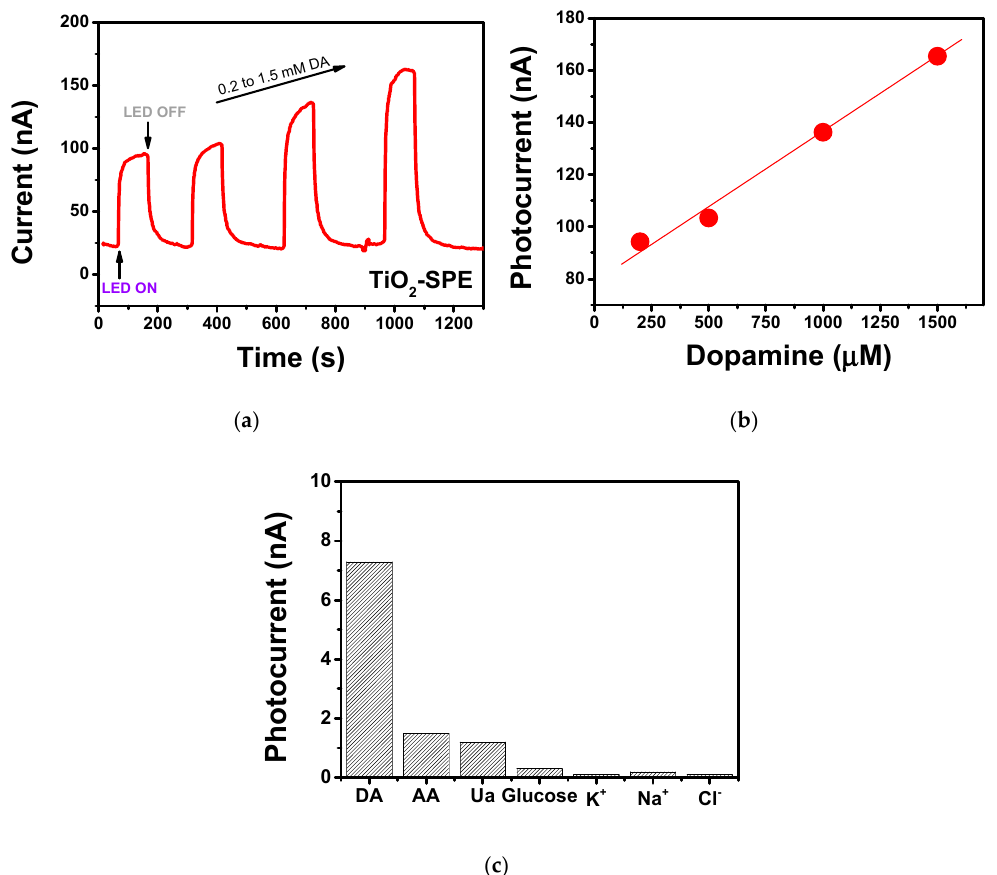
Figure 8. ( a ) Photocurrent signal of the modified photo-electrochemical sensor registered at V Ag/AgCl = 0 under pulses of UV LED light (400 nm) in the presence of different concentrations of dopamine. ( b ) Calibration curve. ( c ) Photocurrent variation registered in the presence of 0.5 mM of DA and some foreign species.